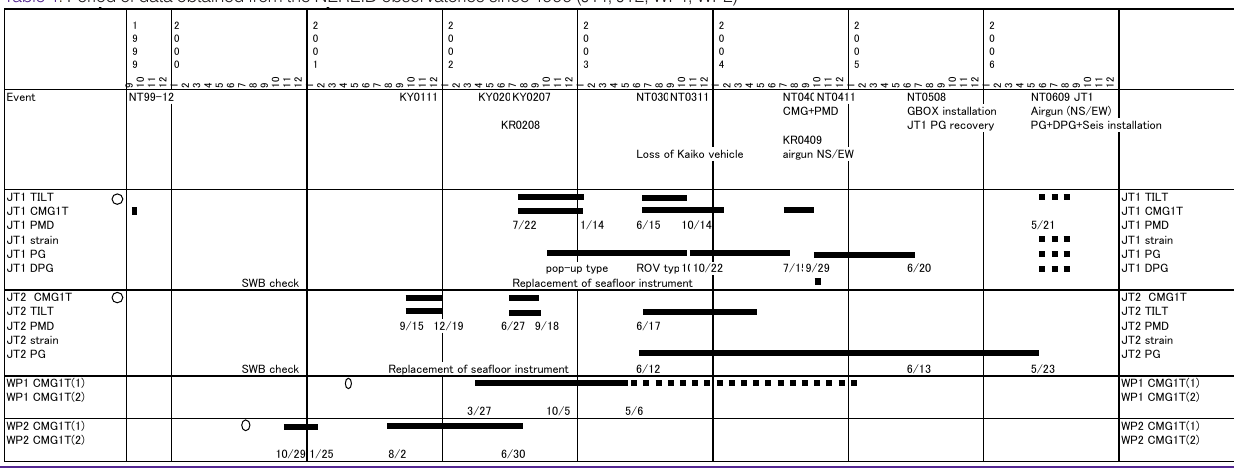
Table 1. Period of data obtained from the NEREID observatories since 1999 (JT1, JT2, WP1,